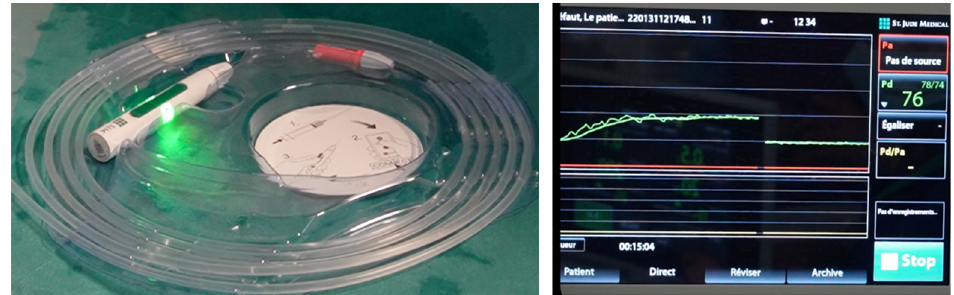
Figure 1. Wireless system. The PressureWire is activated by pressing a button (green light) and au- tomatically connected wirelessly to a console (QUANTIEN system). The zeroing must be completed before the PressureWire placement, outside the patient. Once it is connected, it starts to simultane- ously transmit the pressure signal to the